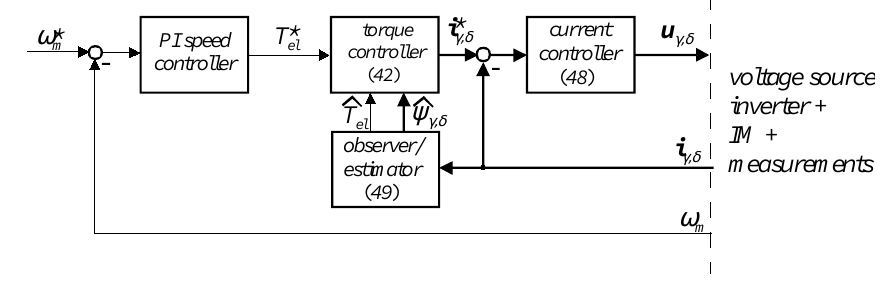
Figure 4. Controller structure for speed